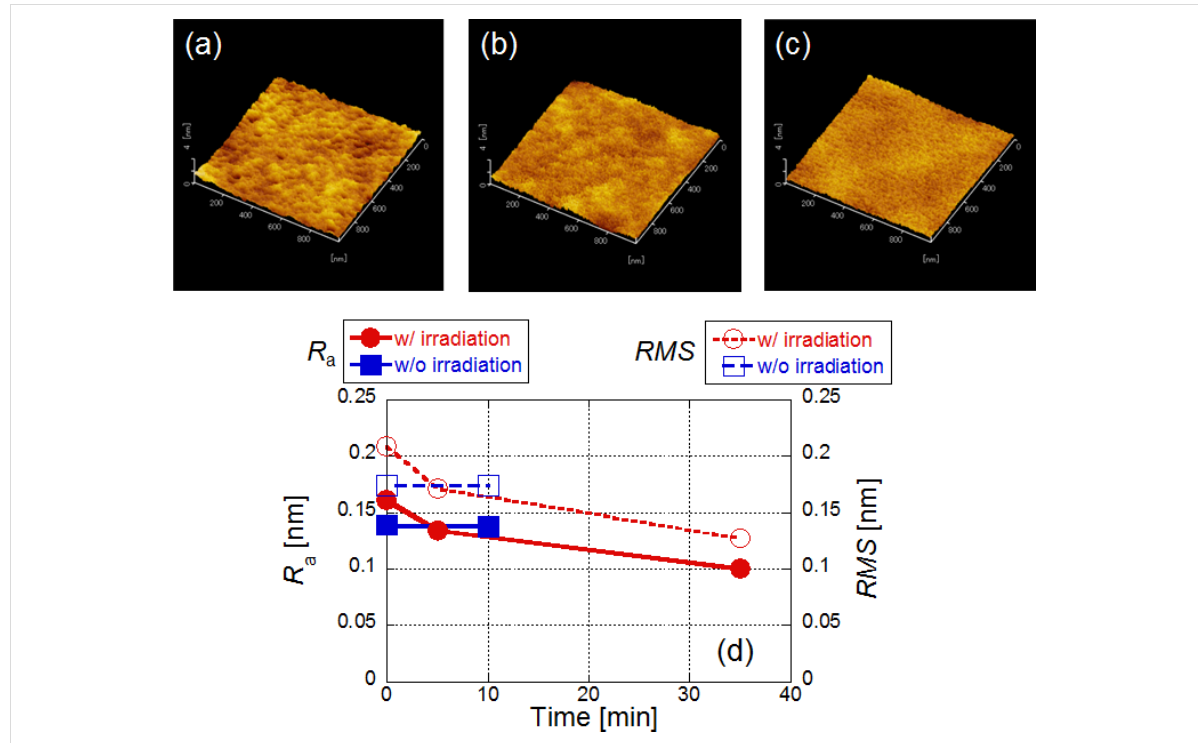
Figure 3: Time dependence of surface roughness using a solution (wet etchng). AFM images taken (a) before etching, (b) after 5 min, and (c) after 35 min. (d) Time dependence of the value of R a . Red solid circles: with irradiation, blue solid squares: without irradiation. Time dependence of the value of RMS (right hand side). Red open circles: with irradiation, blue open squares: without irradiation.